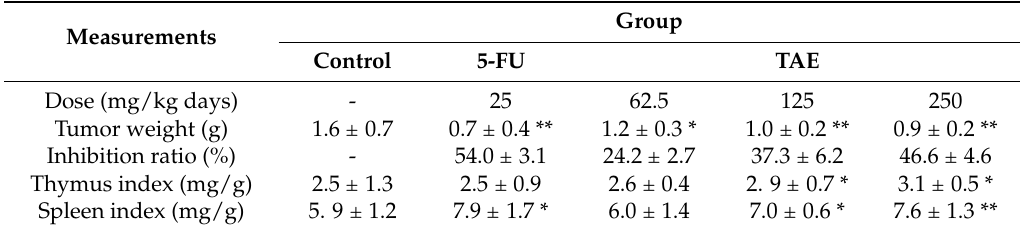
Table 6. Antitumor activity of triterpene acid extract (TAE) from Ganoderma lingzhi against sarcoma 180 solid tumors in mice and the immune effects of TAE.